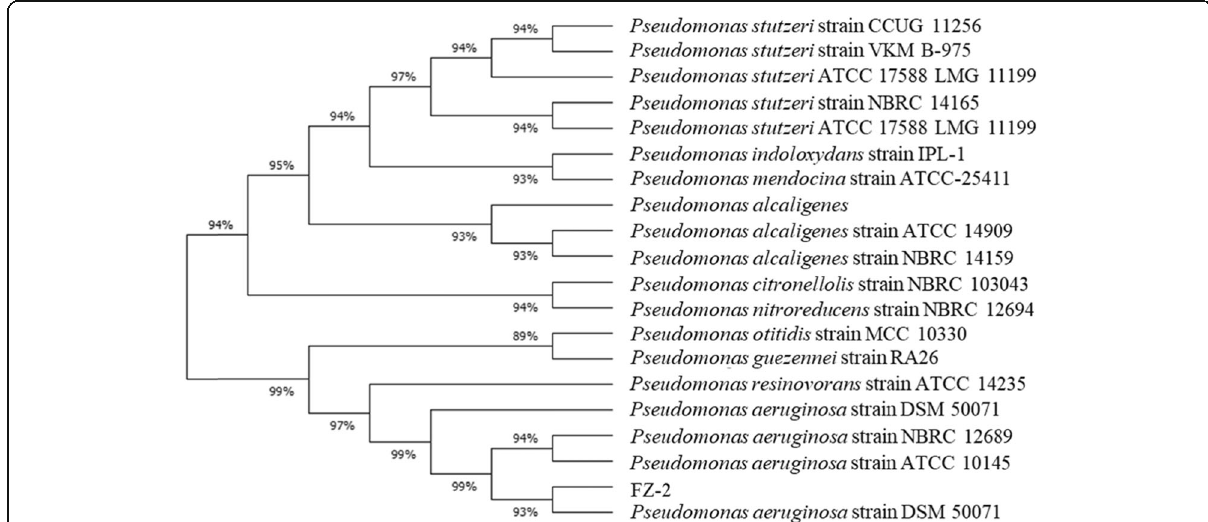
Fig. 2 Neighbor-joining tree showing the phylogenetic relationship between isolates and the reference microorganism based on the 16S rDNA gene